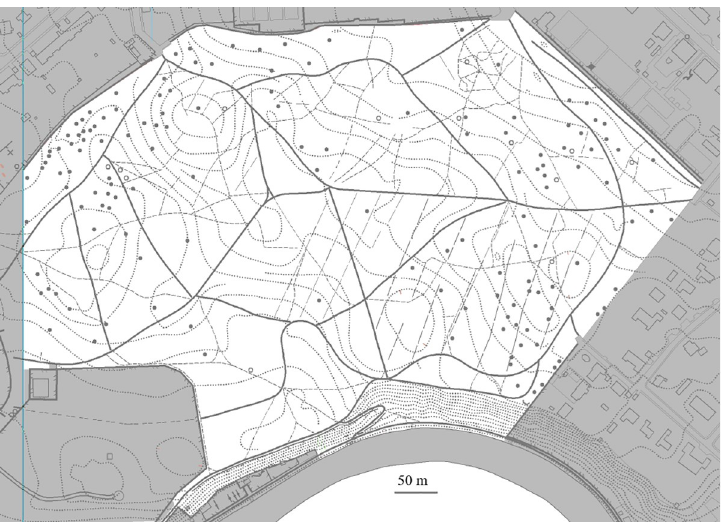
Fig 2. Distribution of sites of Prunus laurocerasus recorded during 2 inspection rounds by the O-map/way method (between all ways) or by the NT-map/way method (only along NT-ways). The shown forest area (in white) is a 30.1 ha large part of target area 714f of forest “Da¨hlho¨lzli” (S1 Table) and is displayed here in a modified and colourless form from the O-map (Reprinted from O-map “Da¨hlho¨lzli”, #1772 Q, under a CC BY license, with permission from OLG Bern, original copyright 2014). From a total of 152 recorded plant sites, 139 were only recorded by the O-map/way method between ways (black dots). The remaining 13 sites (shown as circles) were also found along the ways. (Table 2). The NT-ways are shown as continuous lines, the O-ways as dashed lines, the forest tracks as lines with long dashes, and the contour lines as dotted lines.